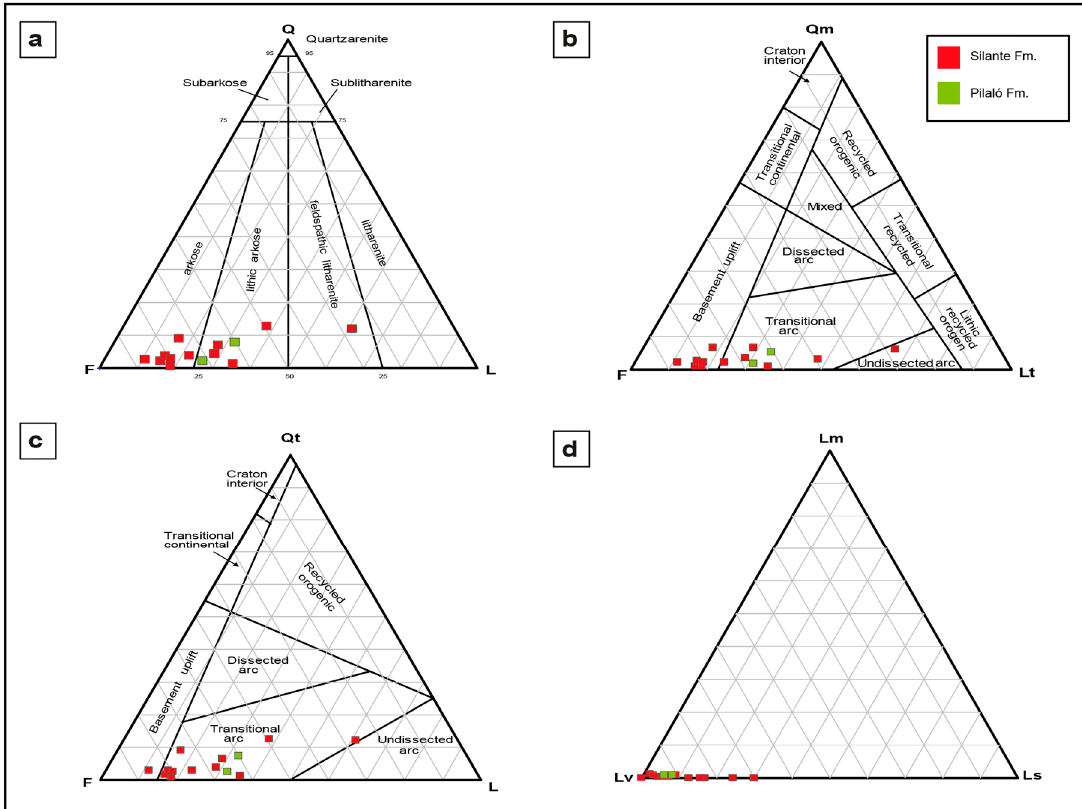
Figure 11. Sandstone ternary diagrams for the Pilalo and Silante formations. ( a ) Ternary diagram with discrimination fields using the terminology of Folk [88]. ( b ) Ternary discriminatory diagram of monocrystalline quartz (Qm), feldspar (F) and total lithics (Lt) after Dickinson [43]. ( c ) Ternary discriminatory diagram of quartz (Qt), feldspar (F) and lithics (L) after Dickinson [42]. ( d ) Ternary discriminatory diagram of metamorphic lithics (Lm), sedimentary lithics (Ls) and volcanic lithics (Lv) after Dickinson [43].